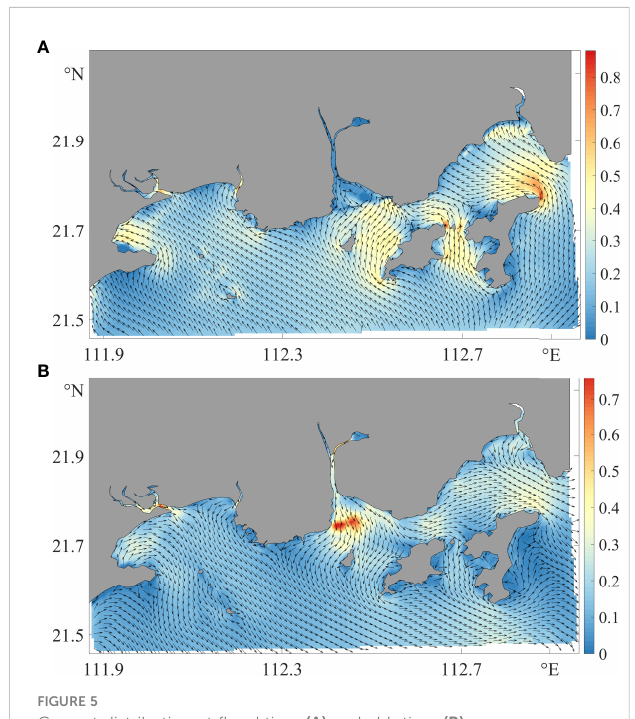
FIGURE 5 Current distribution at fl ood time (A) and ebb time (B)